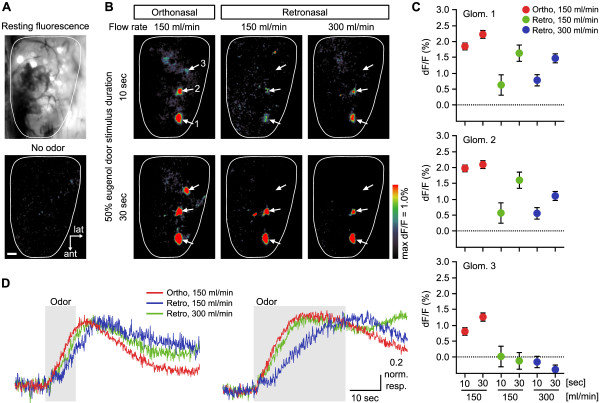
Odor-evoked spH responses to retronasal airflow in the dorsal olfactory bulb. A: Resting fluorescence image of the dorsal olfactory bulb showing spH-labeled glomeruli visible through thinned bone. No glomerular responses were observed in the absence of odor stimuli. Scale bar = 200 μm. B: Glomerular response maps to 50% v/v eugenol presented orthonasally or retronasally under different flow rates and stimulus durations. The pseudocolored images show % change in spH fluorescence from resting fluorescence intensity recorded before stimulus onset. Images were obtained from the same animal preparation. The three numbered white arrows indicate the glomeruli for which odor-evoked responses were analyzed in panels C and D. C: The amplitudes of orthonasal and retronasal responses at different flow rates and stimulus durations. Response amplitudes were quantified for glomeruli #1 – #3 corresponding to numbered arrows in panel B. Each value is the mean ± SE of 3 trials. D: Normalized response traces evoked by 10 s (left) and 30 s (right) stimulus pulses in glomerulus #1. The shaded regions indicate the duration of odor pulses. Red lines indicate orthonasal response traces at a flow rate of 150 ml/min. Blue and green lines indicate retronasal response traces at 150 and 300 ml/min, respectively.